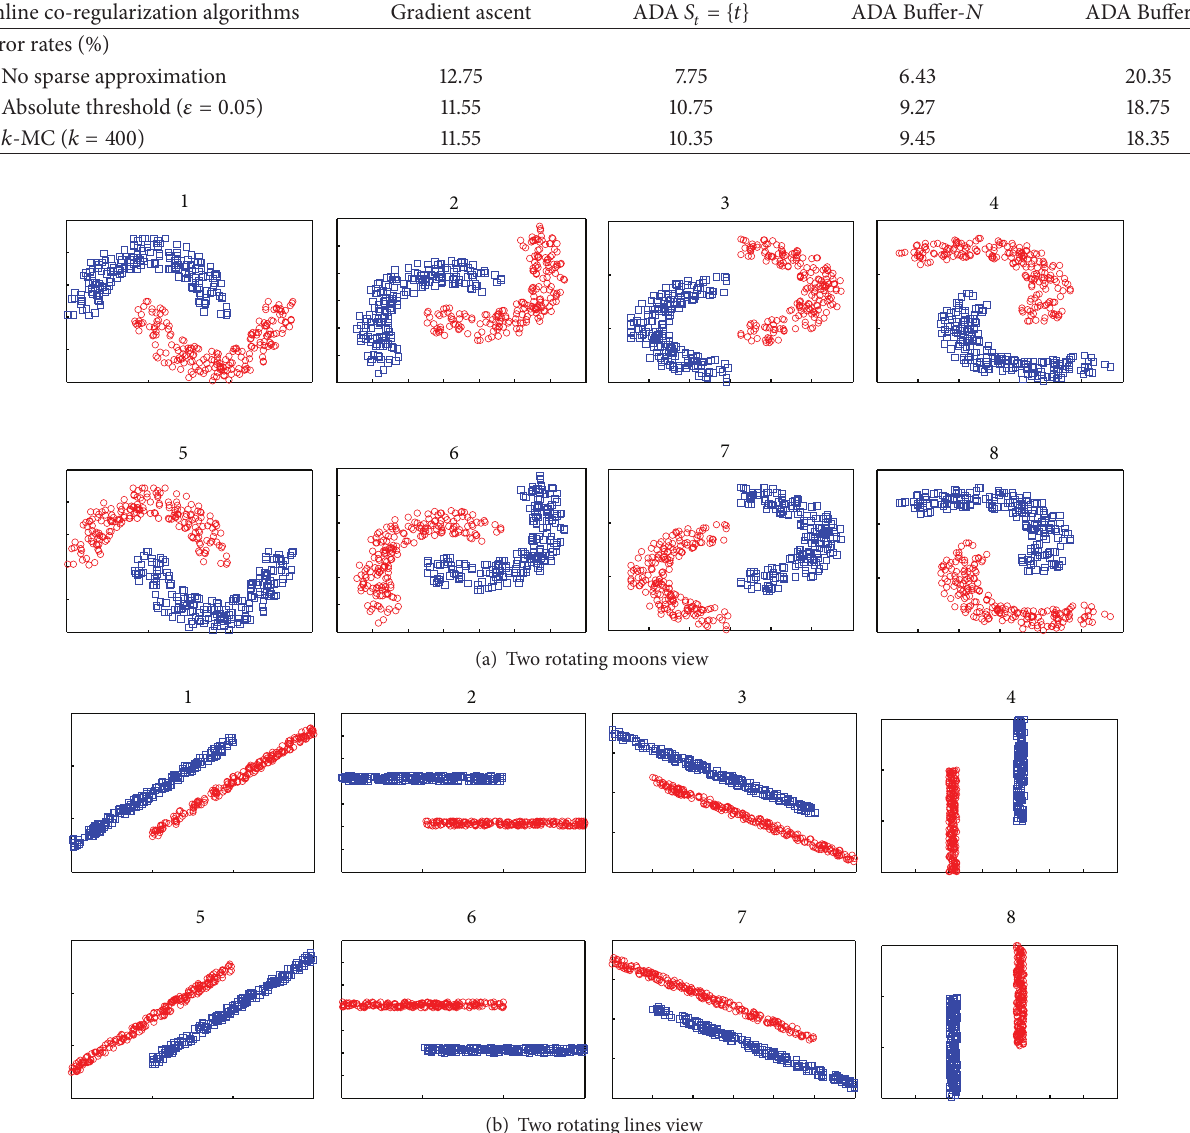
Figure 8: Rotating two-moons-two-lines data sequence. We spin the two-moons-two-lines data set in top left of the two views during the sequence so that two moons and two lines smoothly rotate 360 ∘ in every 8000